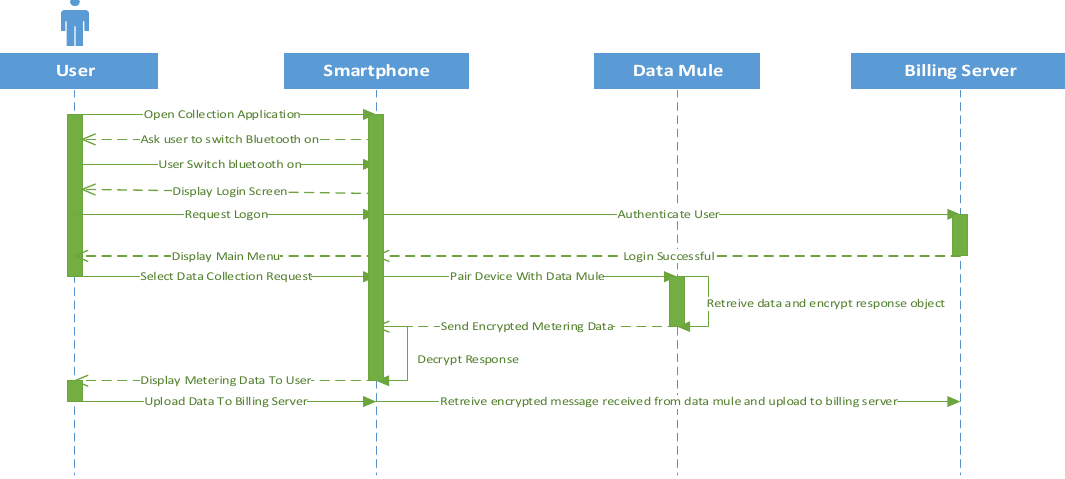
Figure 13. Sequence diagram for retrieving metering data via Bluetooth.